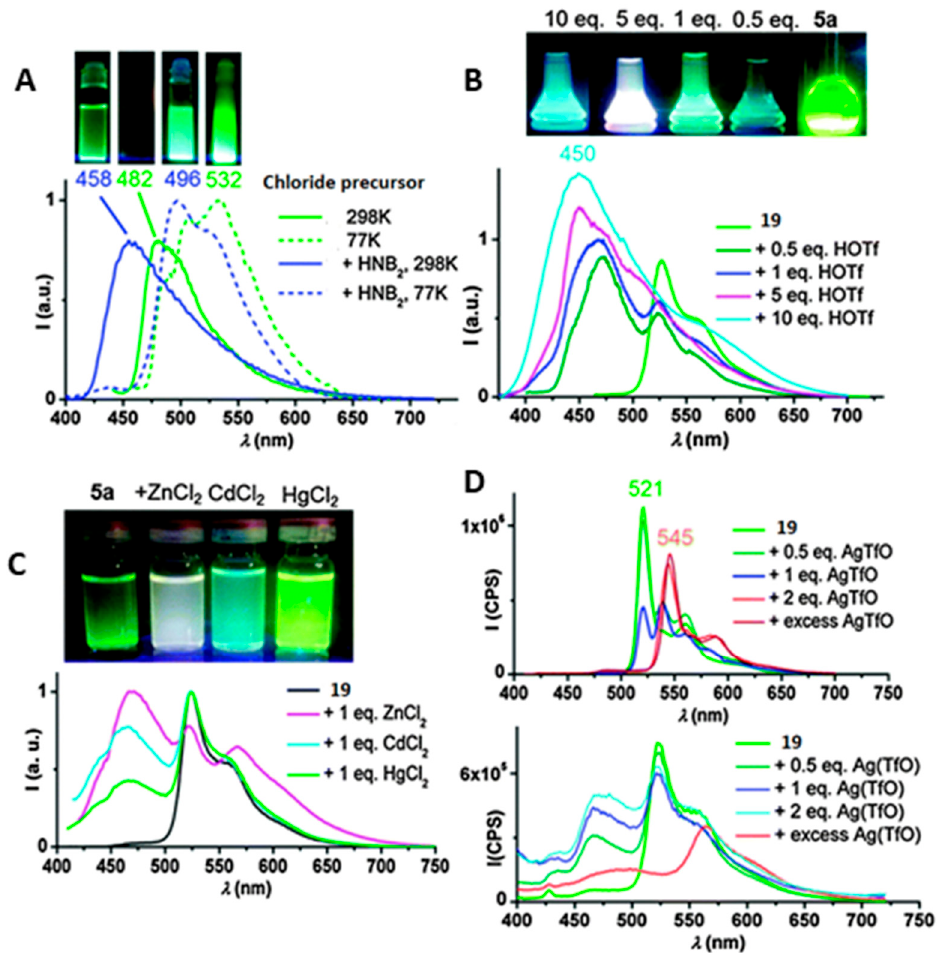
Figure 8. ( A ) Prompt luminescence, PL, of chloride precursor of 19 (CH 2 Cl 2 , 1 × 10 − 4 M) in the absence and presence of two equivalents of [H(OEt 2 ) 2 ][H 2 N{B(C 6 F 5 ) 3 } 2 ] (HNB 2 ) at 298 and 77 K. ( B ) PL response of 19 (CH 2 Cl 2 , 1 ×· 10 − 4 M) to the addition of HOTf at 298 K. ( C ) PL of mixtures of 19 with equimolar amounts of MCl 2 (M = Zn, Cd, Hg) in THFMe-2 ([ 19 ] = 1 × 10 − 4 M) at 298 K. ( D ) PL response of 5a (THFMe-2, 5 ·× 10 − 4 M) to the addition of AgOTf at 77 (top) and 298 K (bottom). Reproduced with permission from Fernandez-Cestau, J. et al., Chem. Commun . published by Royal Society of Chemistry, 2015 [32].